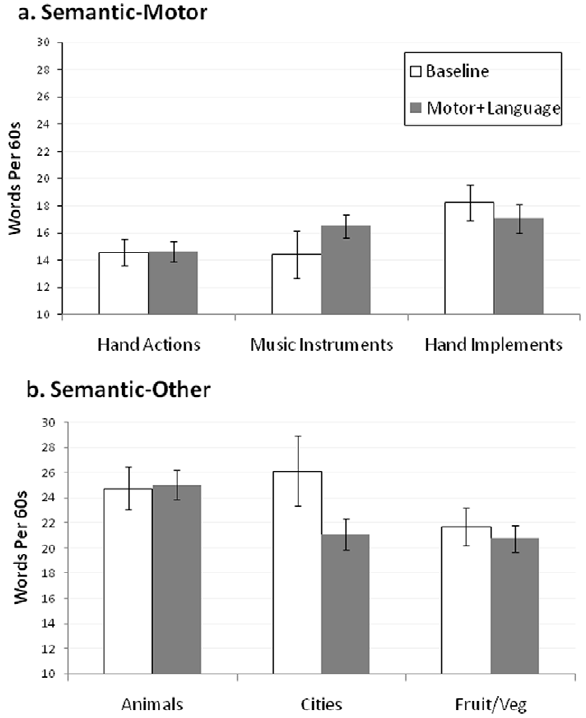
Figure 3. Depiction of word production means during Baseline and Motor + Language conditions for Semantic-Motor and